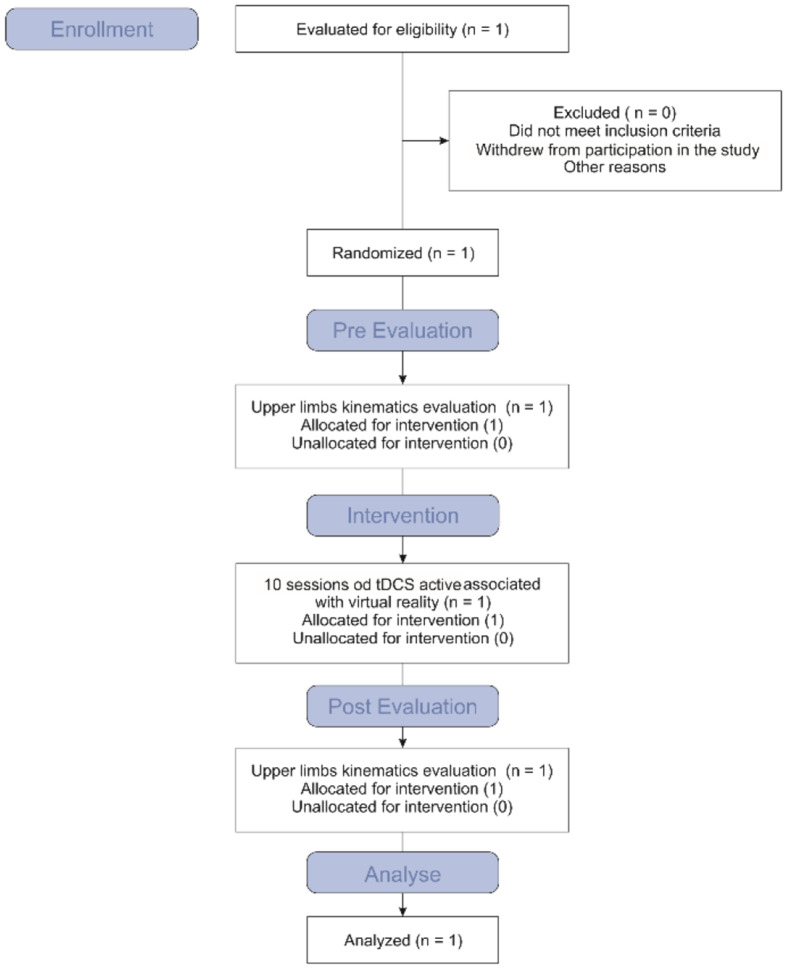
Study flowchart.